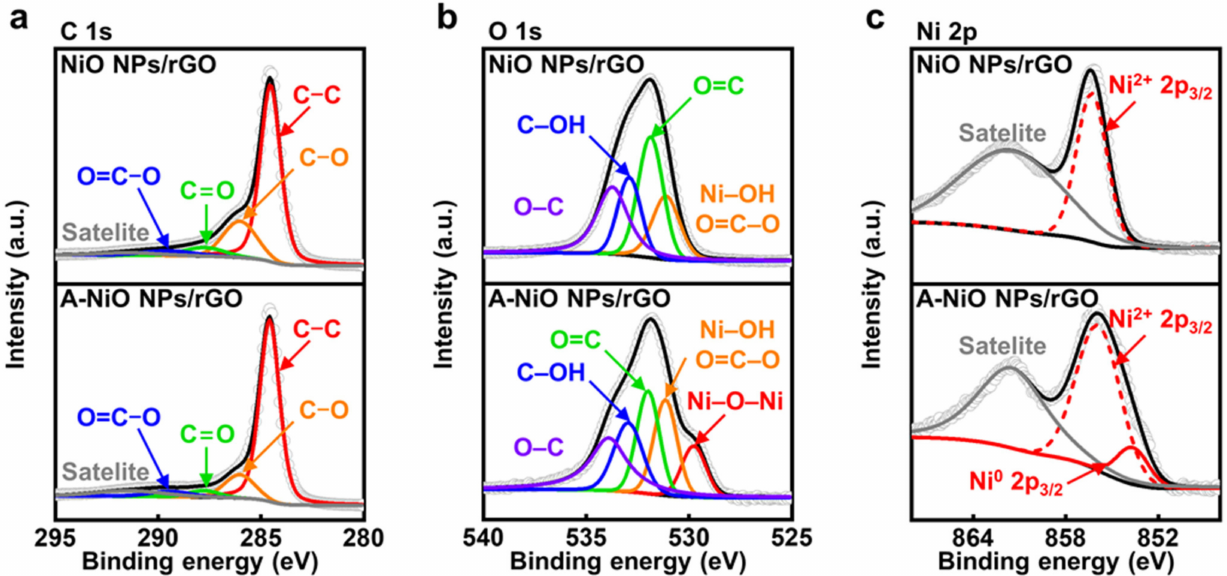
Figure 3. XPS characterizations for thermal annealing. XPS spectra of ( a ) C 1s, ( b ) O 1s, ( c ) Ni 2p 3/2 for NiO NPs/rGO (upper) and A-NiO NPs/rGO